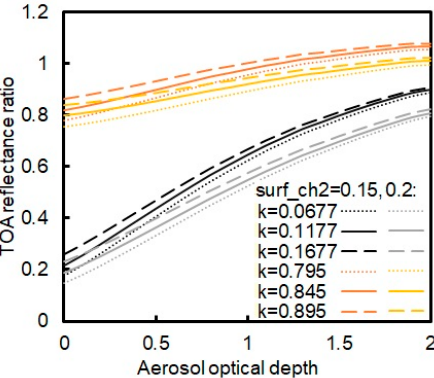
Figure 7. The simulated TOA reflectance ratio of 0.63 to 0.85 μ m as the function of AOD at 0.55 μ m when the solar zenith angle is 22.14°, satellite zenith angle 48°, and relative azimuth angle − 156.41°. The “surf_ch2” indicates a surface reflectance at 0.85 μ m. The 𝑘′ value means the surface reflectance ratio of 0.63 to 0.85 μ m.